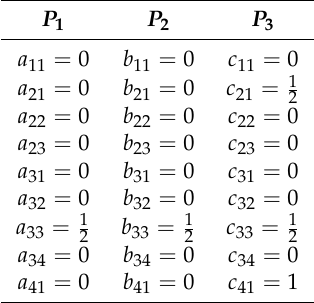
Table 1. Parameter values used for our first Nash Equilibrium agent (NE1). The strategies fall at the “lower bound” of the space of “robust” Nash equilibrium strategies that receive the best worst-case payoff assuming the other agents follow one of the strategies given by the computed infinite equilibrium family. The values are for the free parameters in the infinite family of Nash equilibrium strategies. To define these parameters, a jk , b jk and c jk denote the action probabilities for players P 1 , P 2 and P 3 , respectively, when holding card j and taking an aggressive action (Bet (B) or Call (C)) in situation k , where the betting situations are defined in Table 2. P 1